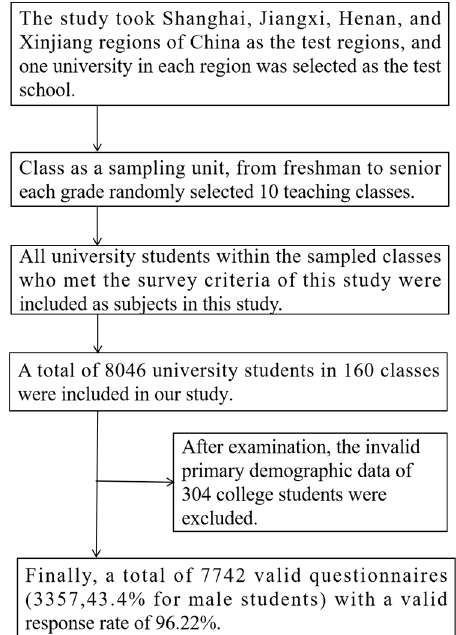
Figure 1. University students’ subject extraction process .